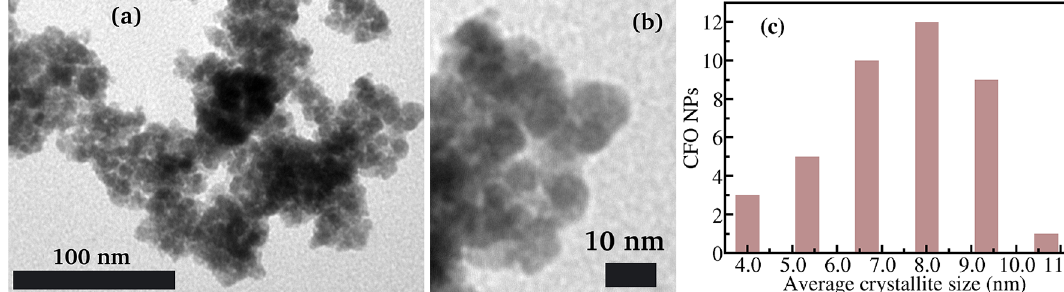
Figure 2. TEM imagens of CFO NPs (two magnifications) and average crystallite size distribution